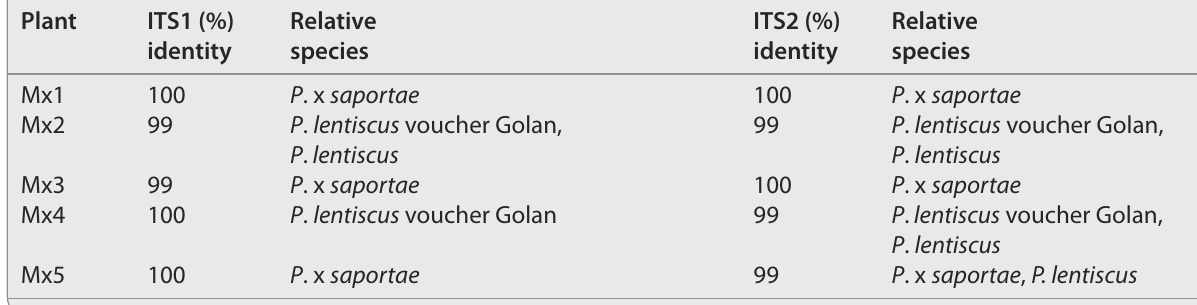
Table 6 Composition of the ITS1 and ITS2 sequences of plants belonging to “Mavroschinos” (Mx) Plant ITS1 (%) Relative ITS2